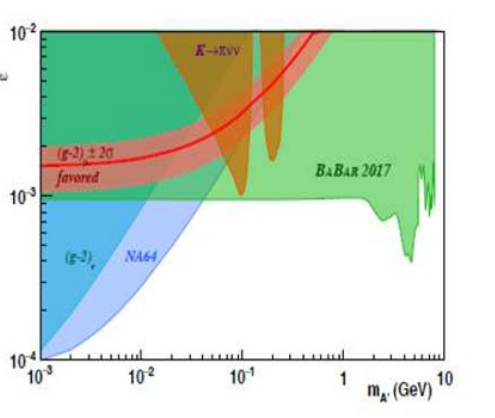
Figure 2. Regions of A ′ parameter space ( ǫ Y vs m A ′ ) excluded by B A B AR analysis [9] of invisible decays, super- imposed to previous constraints and the band preferred at 2 σ for the explananation of the ( g − 2) µ